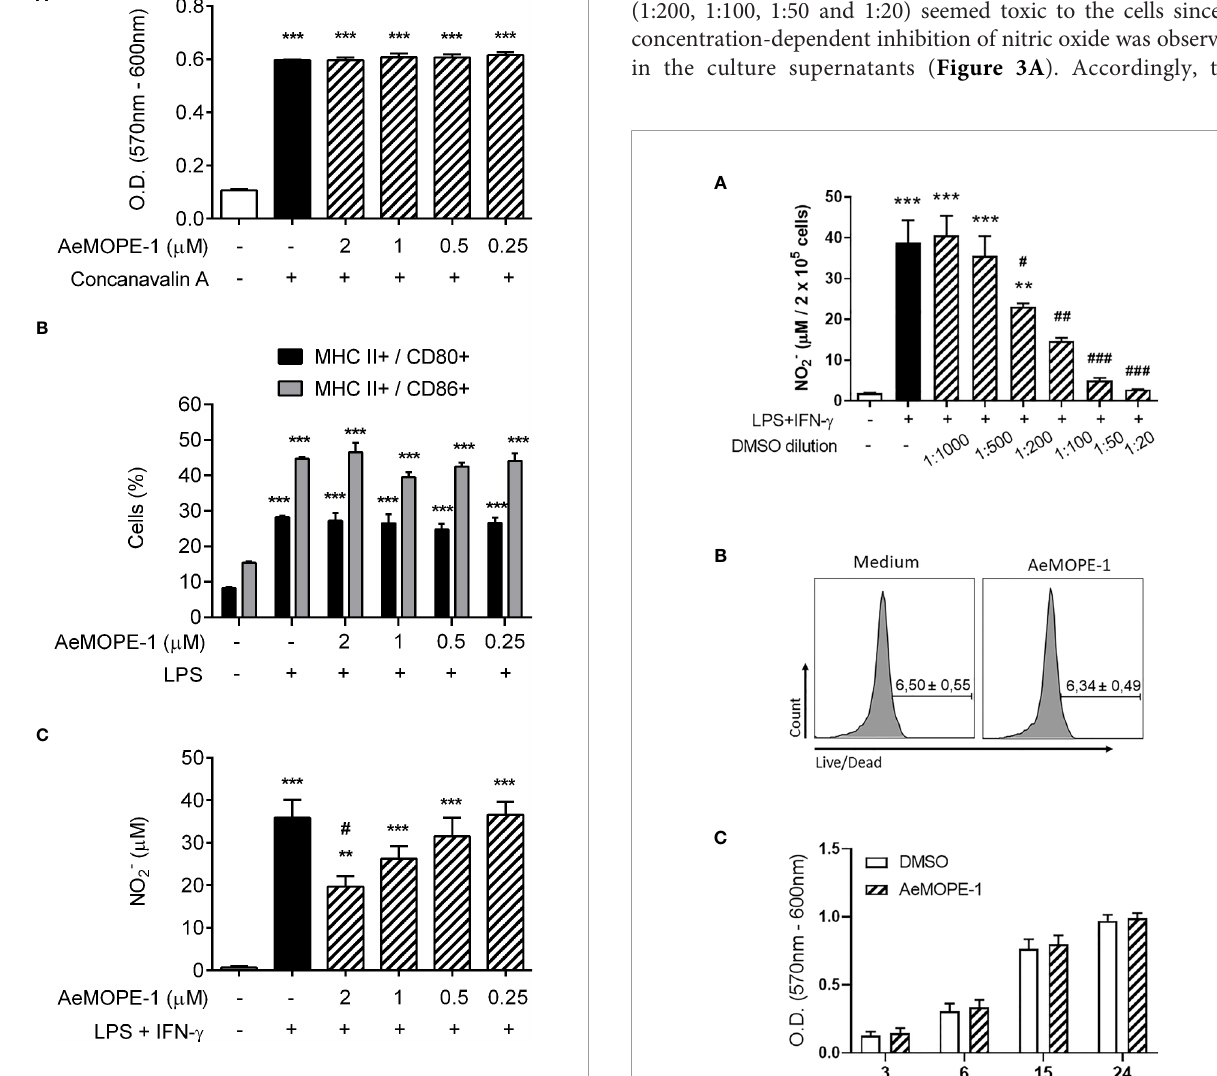
FIGURE 2 | Syn-AeMOPE-1 decreases macrophage production of nitric oxide but does not affect proliferation of T lymphocytes or dendritic cell maturation. (A) Total spleen cells were pre-incubated with syn-AeMOPE-1 (0.25 - 2 µM), stimulated with concanavalin A (0.5 µg/ml) for 72 hours, and the proliferation of T lymphocytes was measured by a colorimetric assay. Results are expressed as the mean ± SEM from one representative experiment of three independent experiments assayed in sextuplicate. (B) Bone marrow-derived dendritic cells were pre-incubated with syn- AeMOPE-1 (0.25 - 2 µM), stimulated with LPS (100 ng/ml) for 24 hours, and the percentage of MHC class II + CD80 + or MHC class II + CD86 + cells were evaluated by fl ow cytometry. Gating strategy and representative plots are presented in Supplementary Figure 2 . Results are expressed as the mean ± SEM from one representative experiment of four independent experiments assayed in quadruplicate. (C) Thioglycolate-elicited peritoneal macrophages were pre-incubated with syn-AeMOPE-1 (0.25 - 2 µM), stimulated with LPS +IFN- g (10 ng/mL of each) for 48 hours, and nitric oxide production was measured by Griess reaction. Results are expressed as the mean ± SEM from one representative experiment of fi ve independent experiments assayed in duplicate. ** P ≤ 0.01 and *** P ≤ 0.001 versus unstimulated/untreated cells; # P ≤ 0.05 versus LPS+IFN- g -stimulated cells – One-way ANOVA.